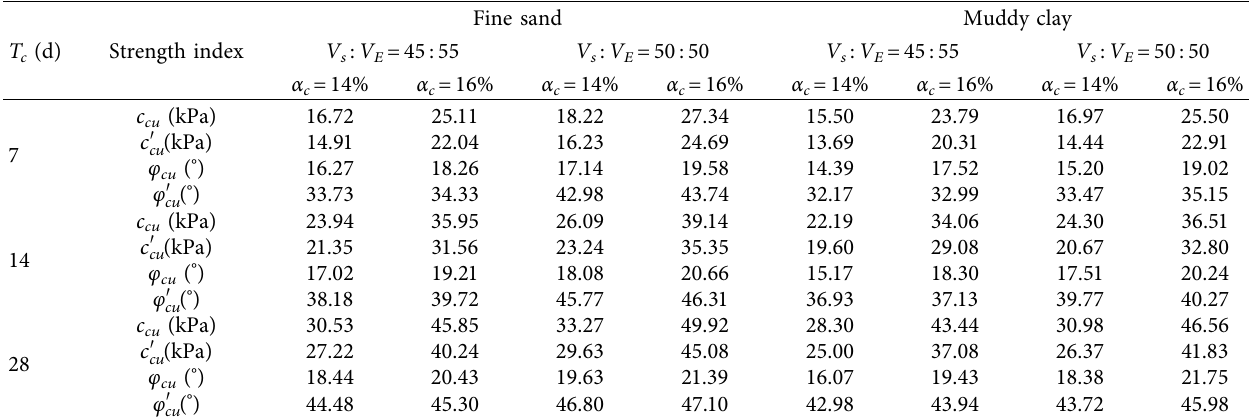
Figure 5: Shear strength test of the muddy clay lightweight: (a) stress-strain curve; (b) failure envelope of the lightweight ( V α c � 16%, and T c � 7d). Table 5: Comparison of the CU test results for different